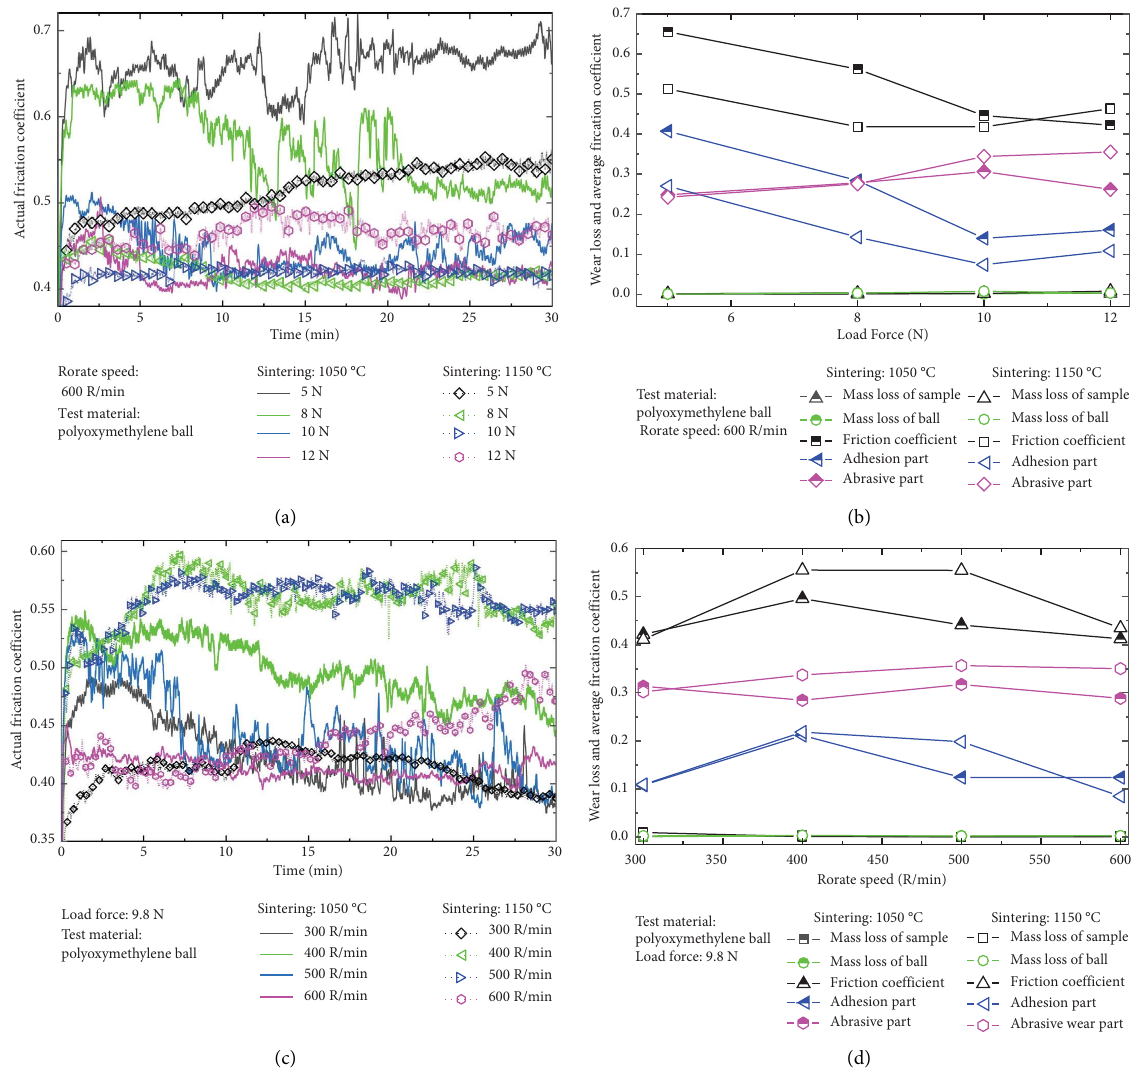
Figure 7: COF (a) and mass loss (b) of the composites with a POM pair under 5–12N; COF (c) and mass loss (d) of the composites at 300–600rpm/min.